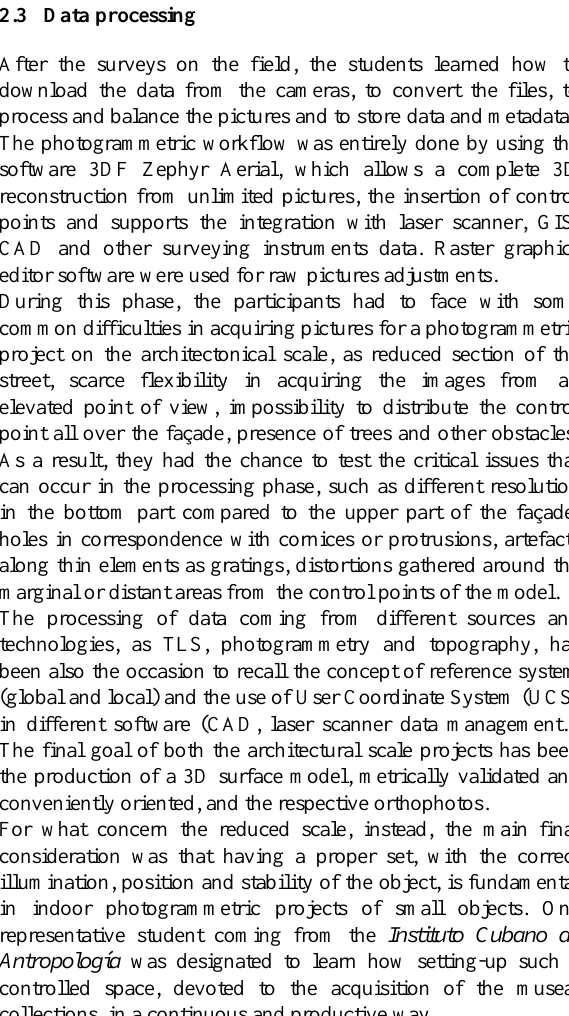
Figure 3. (A) The portal of Casa de la Obra Pía (3D model and orthophoto); (B) graphic representation of integrated survey for the Hostal El Comendador ; (C) feminine pre-colombian figure from the Instituto Cubano de Antropología ; (D) Antonio